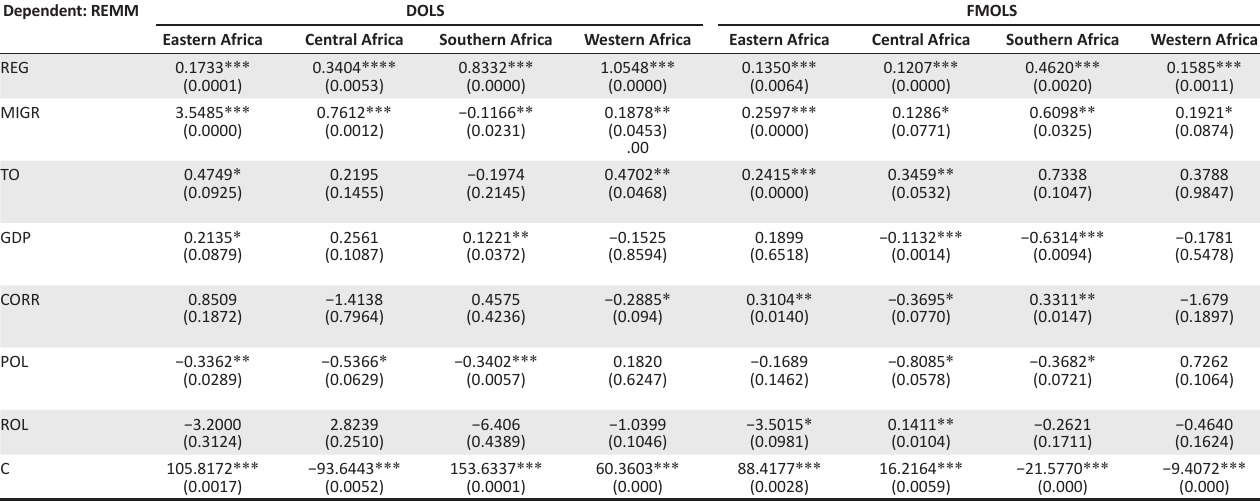
TABLE 6: Region individual regression coefficients. Dependent: REMM